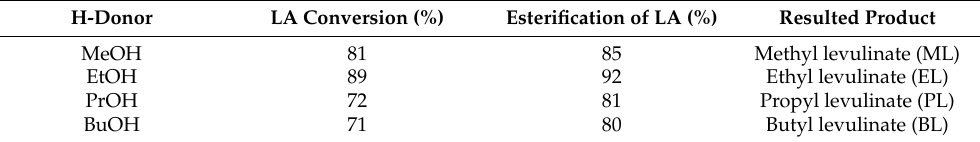
Table 3. ALs synthesis from esterification of LA with various alcohols over Pt/STA-ZrO 2 catalyst.